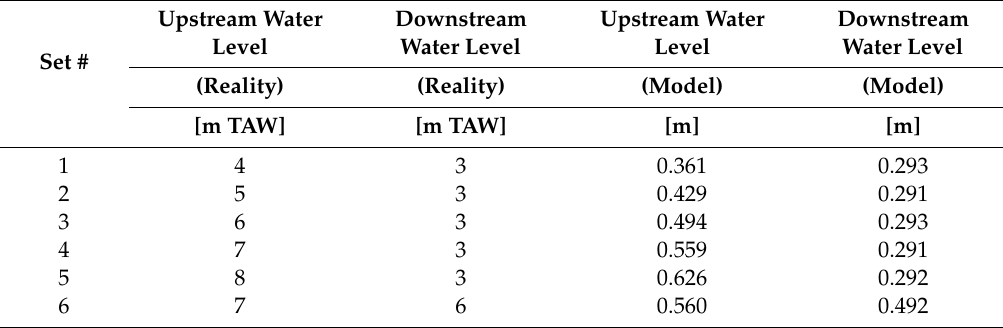
Table 4. List of six sets of up- and downstream water levels for the scale